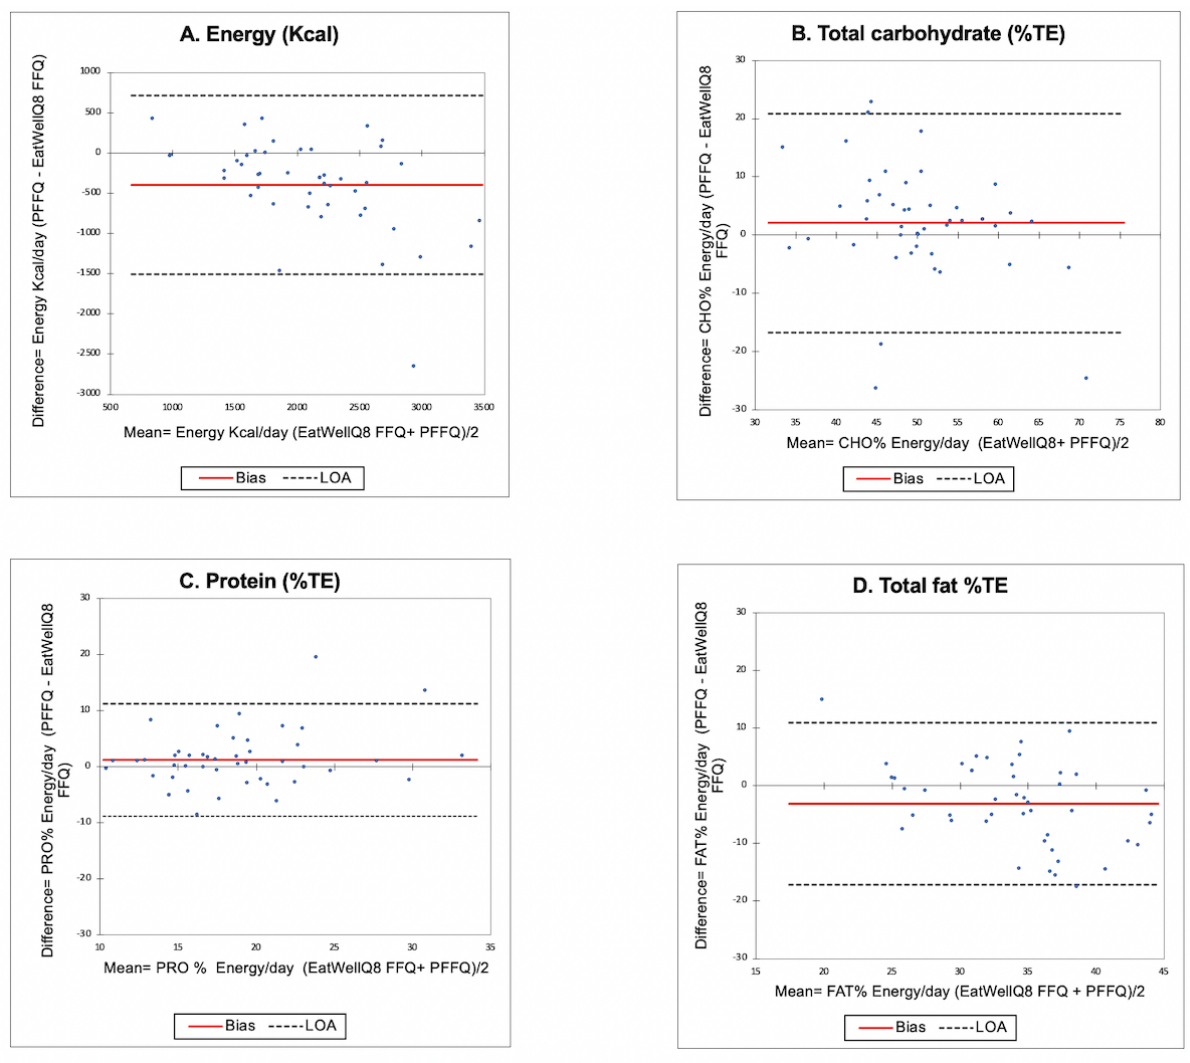
Figure 4. Validation study of Bland-Altman plots comparing the EatWellQ8 food frequency questionnaire (to a paper-based food frequency questionnaire for (a) energy, (b) total carbohydrate, (c) protein, and (d) total fat with the bias (mean difference) and limits of agreement. The solid line represents the bias (mean difference), and the dotted lines represent the limits of agreement. %TE: percentage total energy; CHO: carbohydrates; FFQ: food